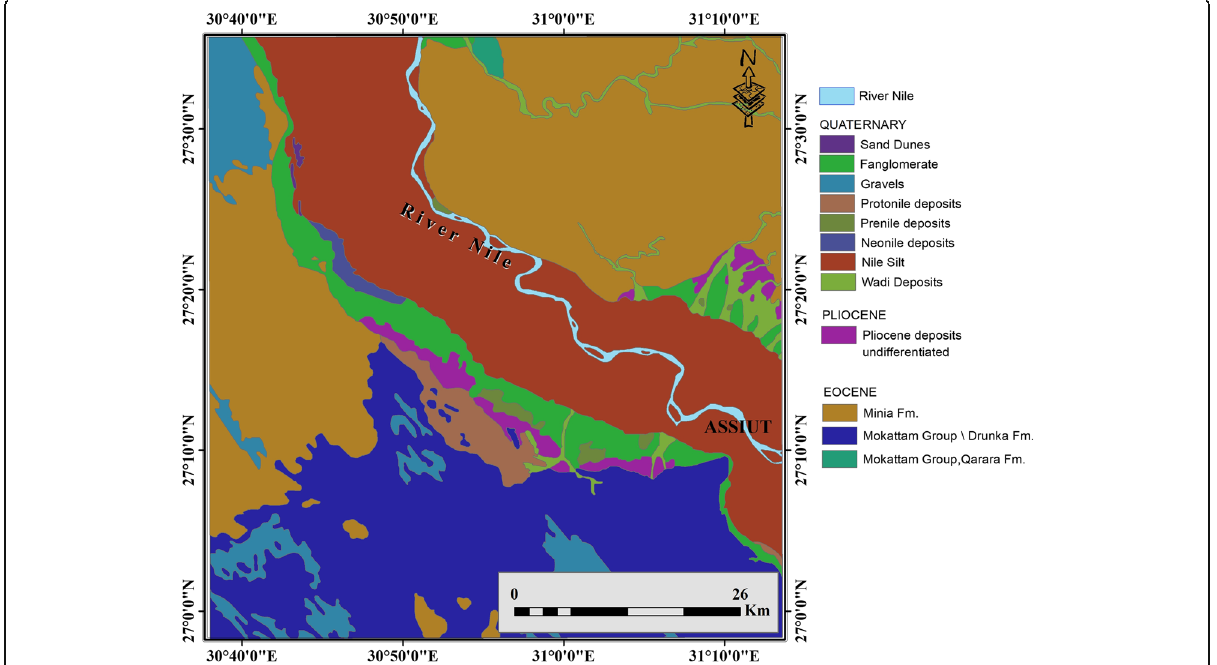
Fig. 2 Lithologic map of the studied Assuit area (After Conoco, Geologic map of Egypt 1987)